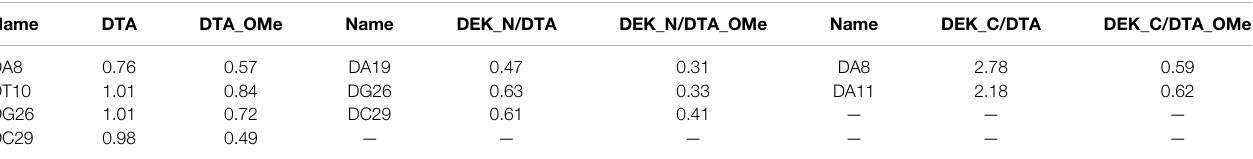
TABLE 1 | RMSF values of some key nucleotides in the individual aptamers and protein – DNA complexes (unit: